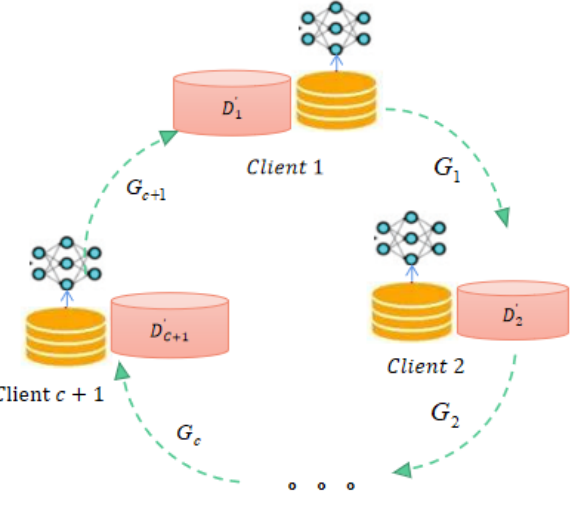
Figure 3. A schematic diagram of the distribution information sharing